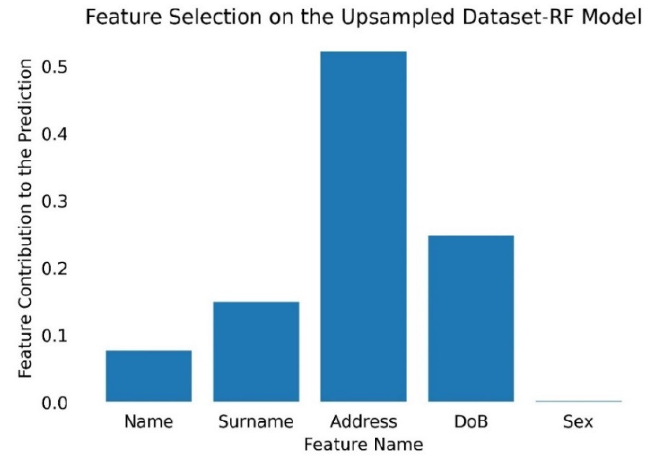
Figure 4. Feature importance of the NN model using the imbalanced dataset as input.